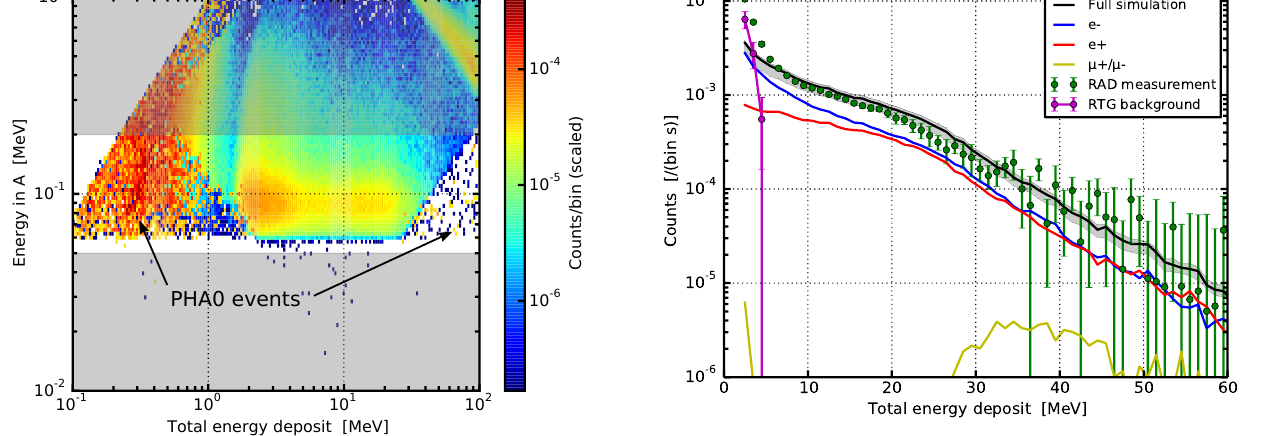
Figure 5. RAD stopping particle measurement for sol 400–500. As in Fig. 3, the gray area marks invalid electron/positron events. Sin- gle bins with high intensity are caused by PHA0 events, which have a large scaling factor. The corresponding measurement histogram is shown in Fig. 6.